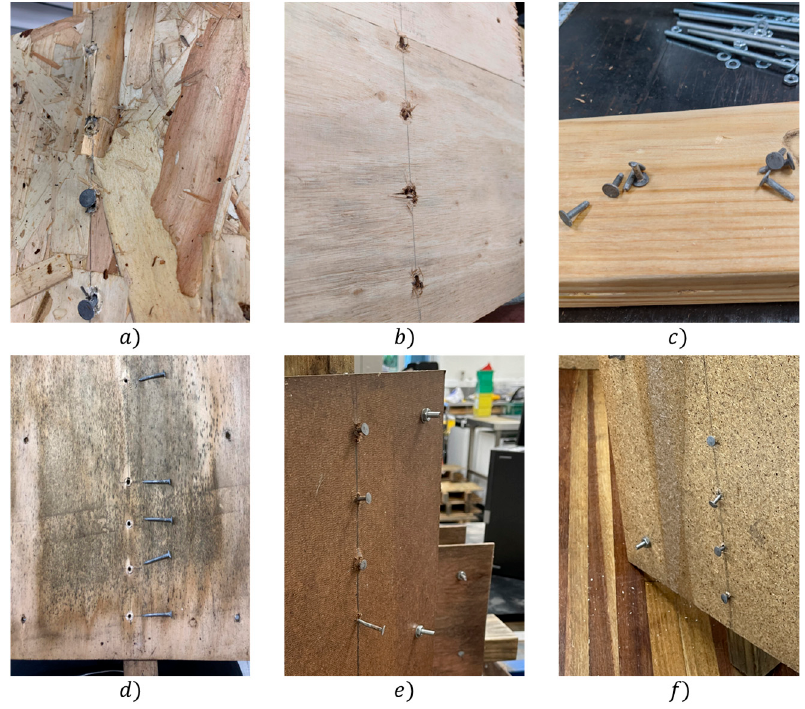
Figure 14. Photos of STC failures on ( a ) OS8, ( b ) & ( c ) HP6, ( d ) WSP5, ( e ) WWU7, and ( f ) WPB5.